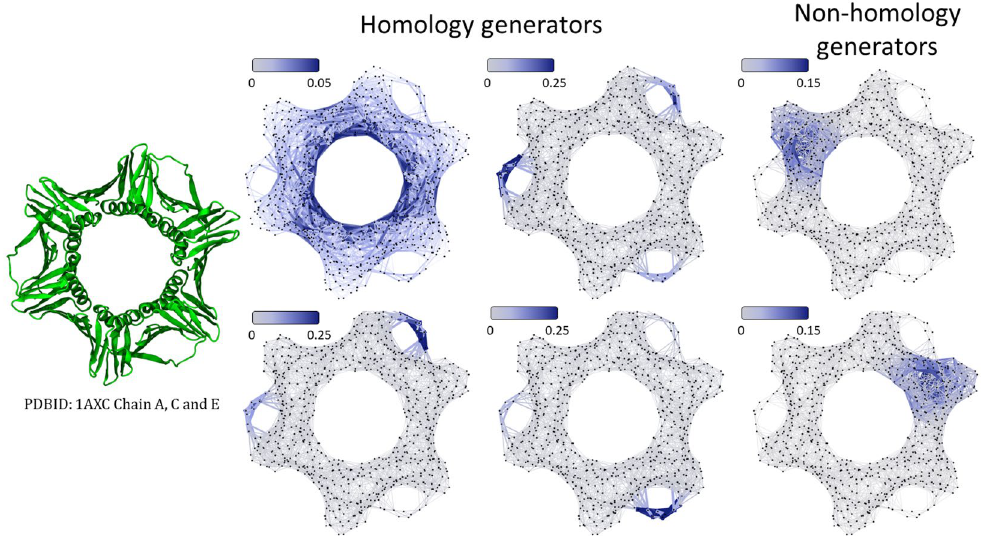
Figure 4. HL-based protein structure analysis for protein (ID:1AXC). Four 1D homology generators are from four zero eigenvalue related eigenvectors of 1D HL matrix. Two non homology generators are from two smallest nonzero eigenvalue related eigenvectors. Homology generators characterize loop and cycle structures, while non-homology generators indicate information about domains and